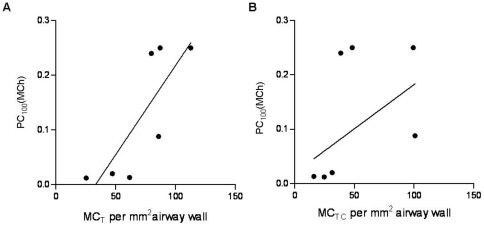
Relationship between mast cell density and airway responsiveness.Correlation between the percent dose of methacholine required to increase Rp by 100% (PC100[MCh]) from baseline and (a) MCT (rs = 0.92, P<0.01) and (b) MCTC.